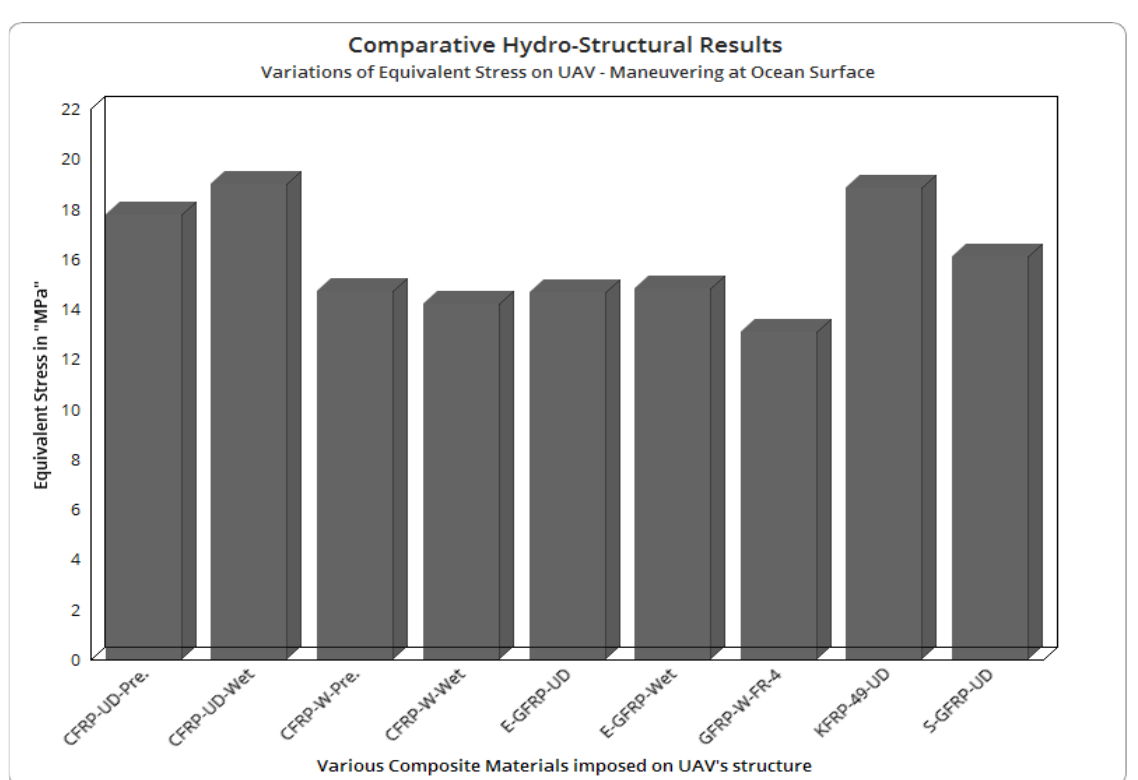
Figure 25. Comparative equivalent stress variations for various alloys.